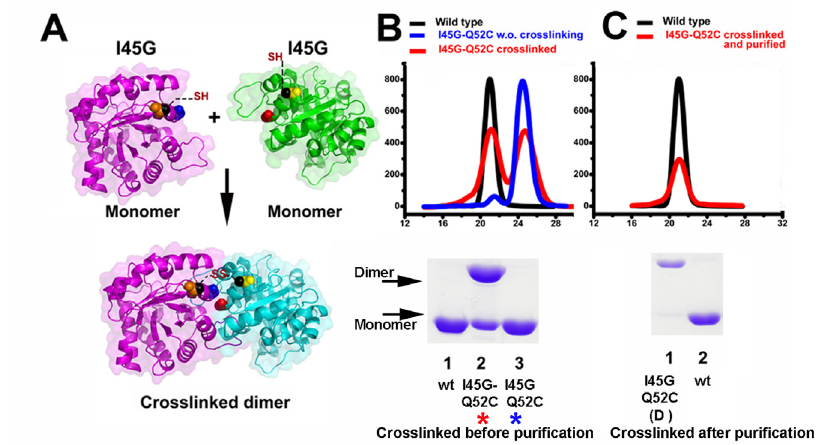
Fig 10. Disulfide Cross-linker induced dimerization of I45G mutant. (A) Localization of the engineered I45G-Q52C double mutant. The upper panel represents the monomeric I45G-Q52C double mutatn that may assemble as a dimer by effect of a cross-linking reaction (lower panel) (B) Gel filtration elution profiles and SDS-PAGE analysis for wild-type and I45G-Q52C double mutant before and after cross-linking. Approximately two thirds of the I45G-Q52C double mutant cross-linked in to a dimer as assessed by SDS-PAGE (lane 3 bottom panel). The differences between the percentage of assembled dimer by SDS-PAGE and gel filtration may due to a differential in the exposure of aromatic residues between the monomer and dimer (C) Gel filtration elution profiles and SDS-PAGE for wild-type and purified cross-linked I45G-Q52C double mutant. The gel filtration step efficiently separates the cross-linked I45G-Q52C double mutant from the unreacted protein (lane 1 bottom panel). The elution profiles have been normalized to ease